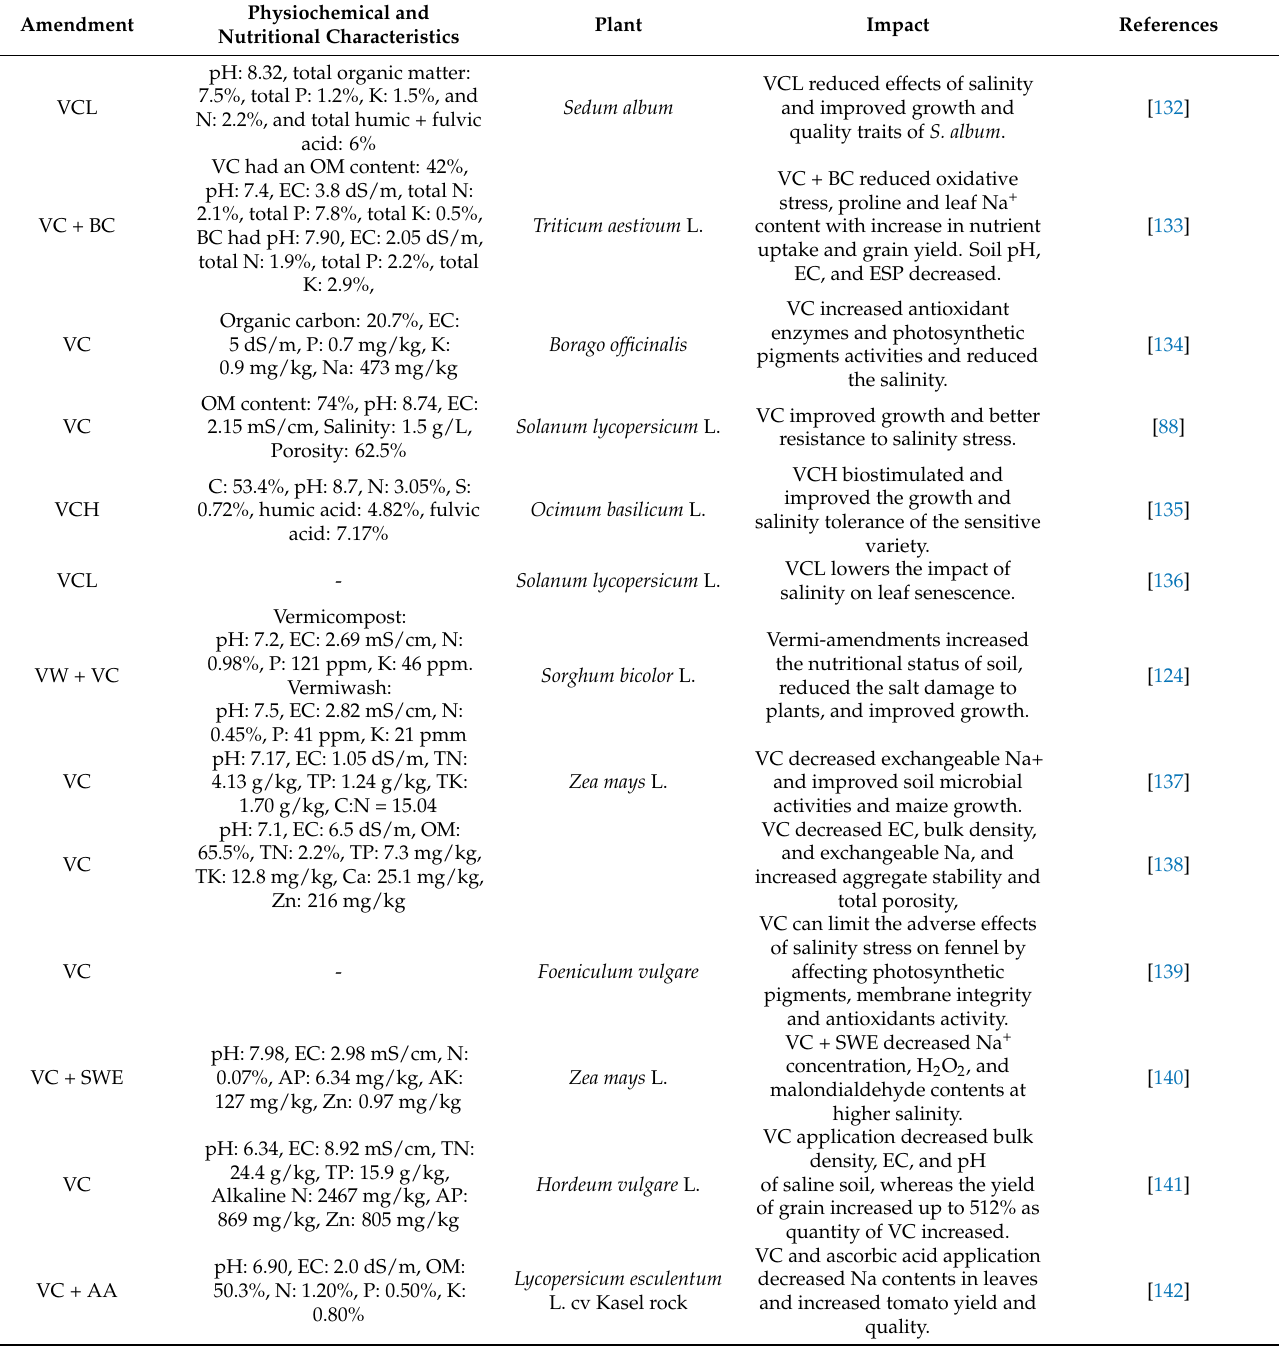
Table 2. Impact of vermicompost and its derivatives on soil properties and plant performance under saline